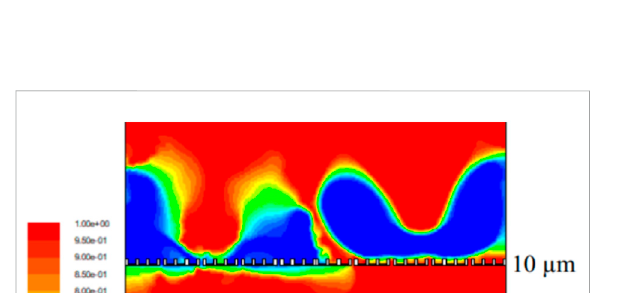
FIGURE 6 Cloudpictureoftheoil – watervolumefractionatavelocityof 0.1, 0.5, and 1 m/s.